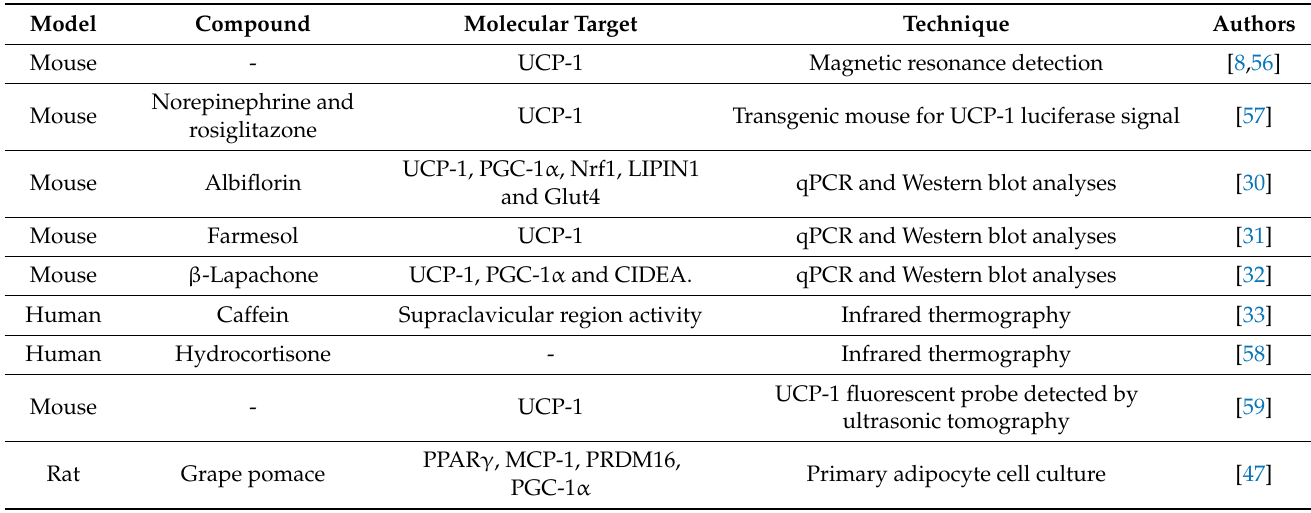
Table 4. Research about thermogenic characteristics and molecular elements related to the phe- nomenon of browning in in-vivo models and clinical